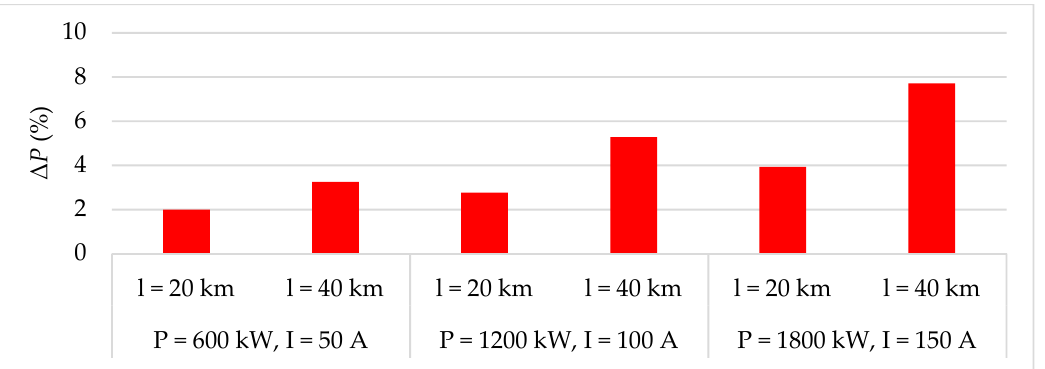
Figure 24. The comparison of the APLs for three types of active powers for conductor ACSR 42 / 7.